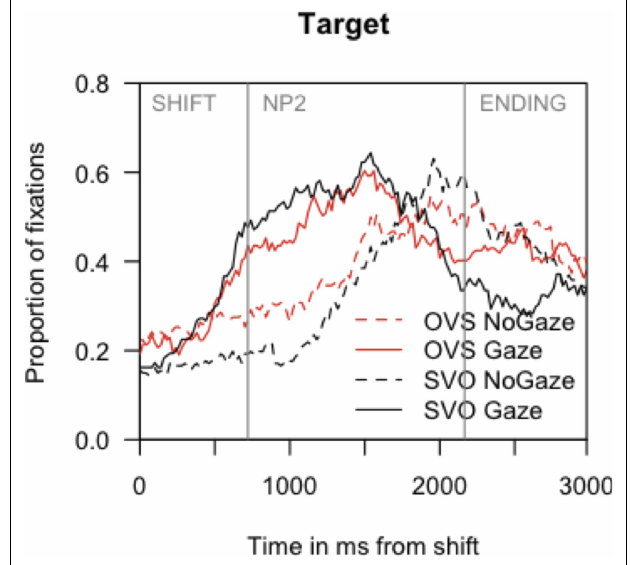
FIGURE 3 | Experiment 2: Proportion of fixations to the target character from the onset of the speaker’s gaze shift. Mean onsets of the NP2 and the ending phrase are marked with vertical gray bars.